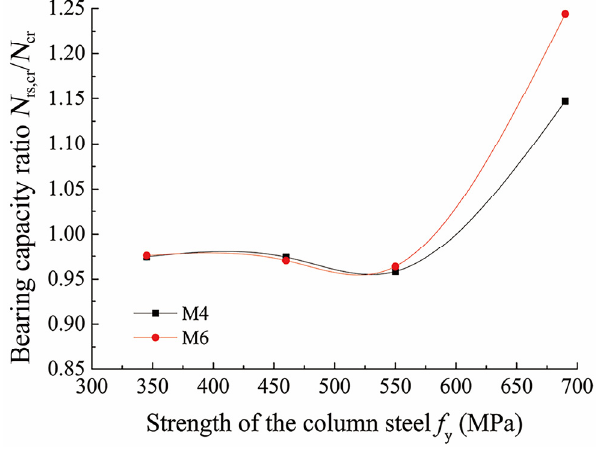
Figure 12. Influence of welding residual stress on bearing capacity of columns with varying steel strengths.